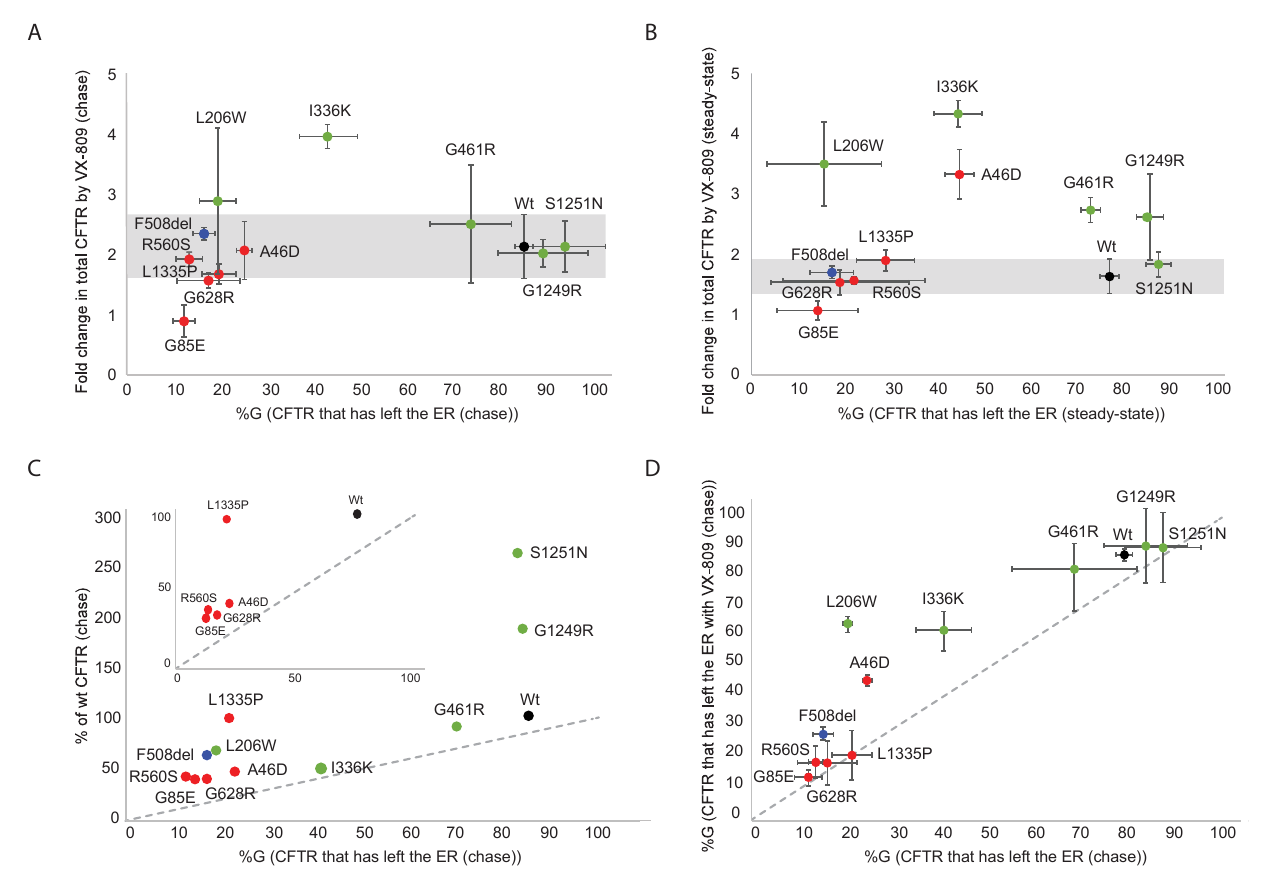
Figure 7. Modulators have comparable effects on hypo- and hyper-responding CFTR mutants ( A ) Fold change in (mutant) CFTR levels (ER+G) by VX-809 ( y -axis) at 2 h of chase plotted against the percentage CFTR that had left the ER after 2 h of chase (G/(ER+G)) in the DMSO control ( x -axis) (n ≥ 3 for each mutant, including data from Figures 4 and 6). The cut-off for a wild-type-like VX-809 response, shown as a light grey bar, is the standard deviation of wild-type CFTR samples ( n = 6). Hypo-responder mutants are depicted in red and hyper-responders are depicted in green. ( B ) As in ( A ), but in steady-state. Graphs include data from Figures 1 and 5. ( C ) CFTR (ER + G) that is present at 2 h of chase, quantified from Figures 4 and 6, as percentage of wild-type CFTR ( y -axis), plotted against the percentage of CFTR that had left the ER at that time point (G/(ER + G)), both in DMSO control ( x -axis). Insert shows the hypo-responder mutants in the same plot with a y -axis to 100%. ( D ) The percentage CFTR that had left the ER after 2 h of chase in the presence of VX-809 ( y -axis) plotted against the percentage CFTR that had left the ER after 2 h in the DMSO control ( x -axis). Error bars correspond to quantifications of at least three independent experiments, including data from Figures 4 and